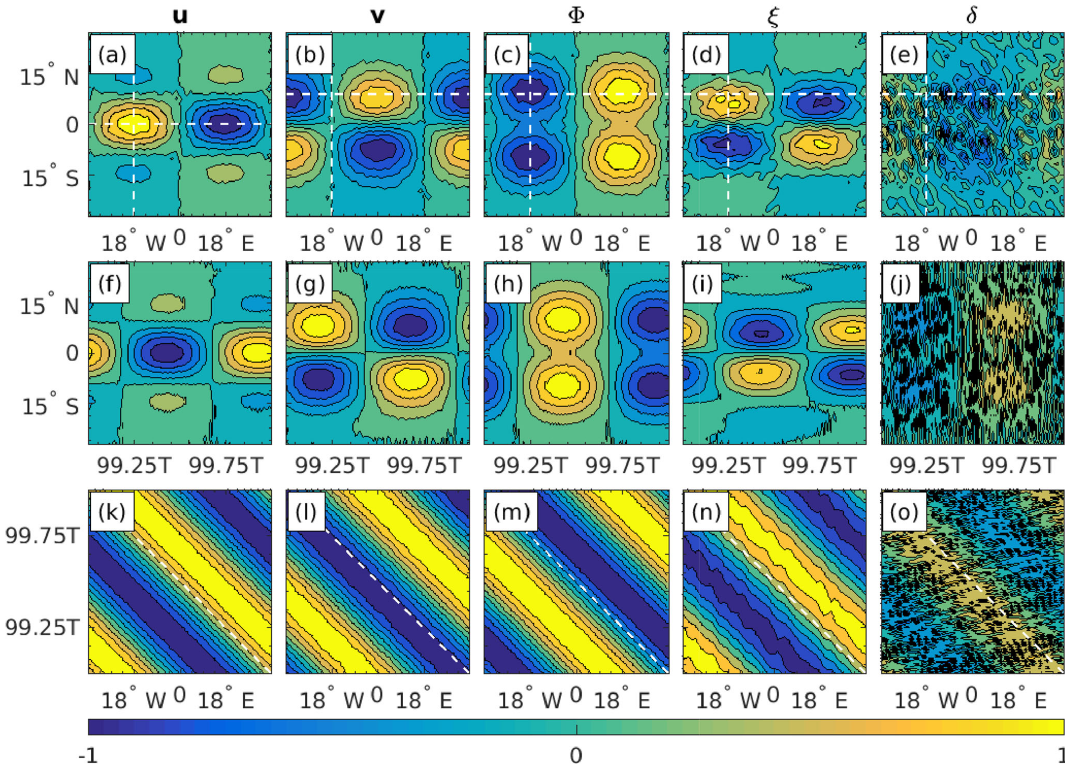
Figure 7. Same as Fig. 4, but for the perturbed Rossby